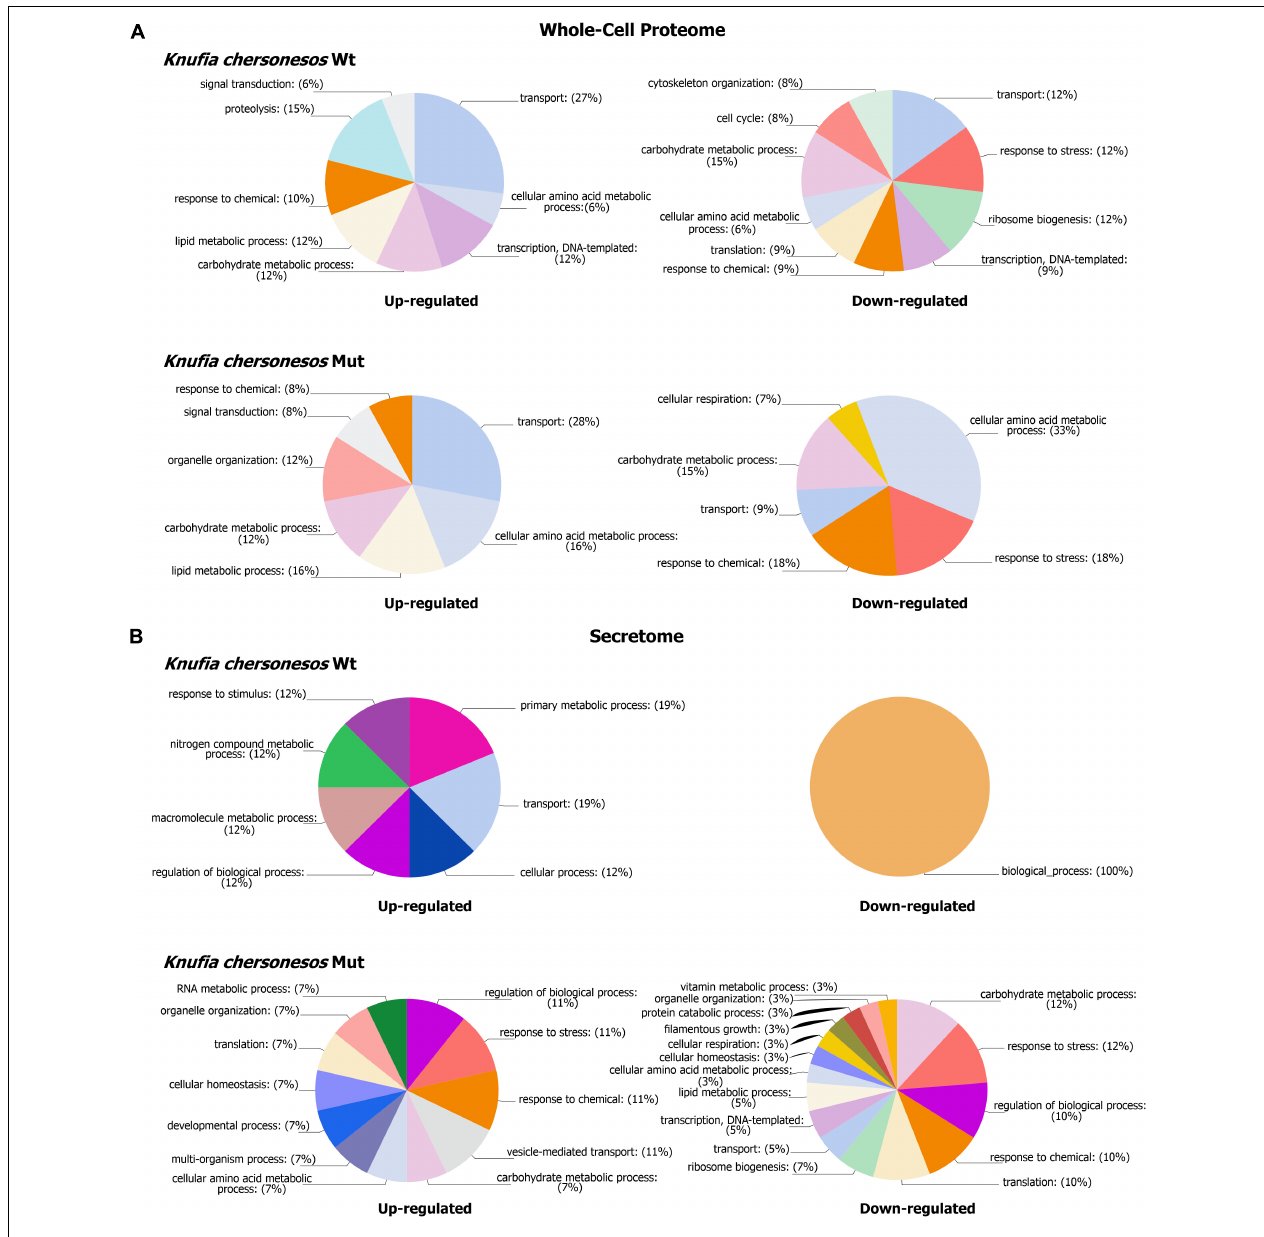
FIGURE 5 | Biological processes GOs categories of differentially expressed proteins in Knufia chersonesos under LSSMG. (A) Whole-cell proteome (B) Secretome. Proteins with changed abundance (FC ≥ ± 1.5, p ≤ 0.05) were annotated with terms representing various biological processes using OmicsBox v. 1.4.11 (https://www.biobam.com). GO terms were thereafter summarized using sequence distribution/GO multilevel pie charts (Filtered by sequence count, Cutoff =